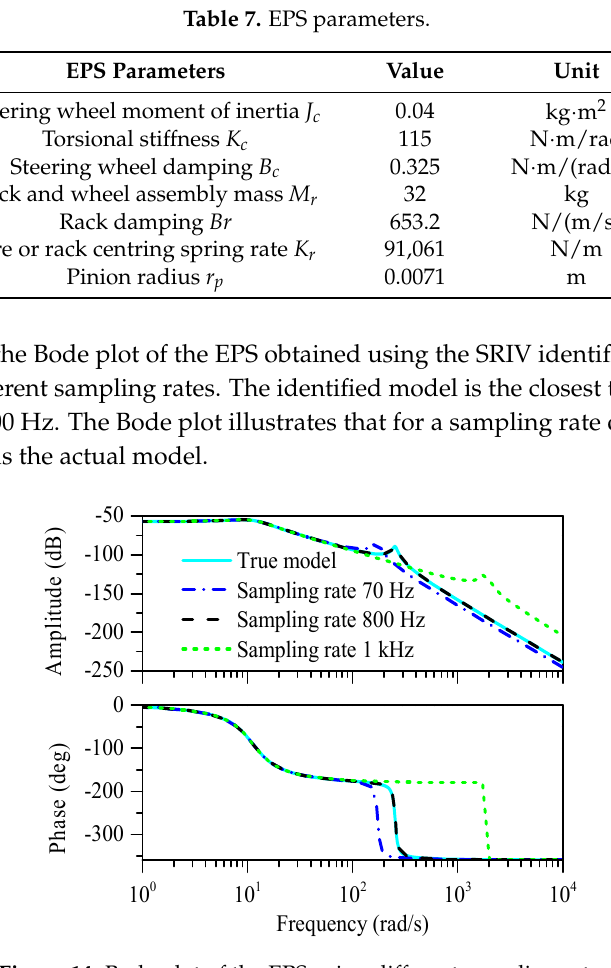
Figure 15. Bode plot of the EPS using different identification algorithms.